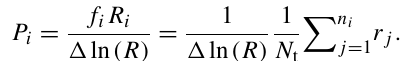
sidered non-precipitating and thus excluded). In TRMM,